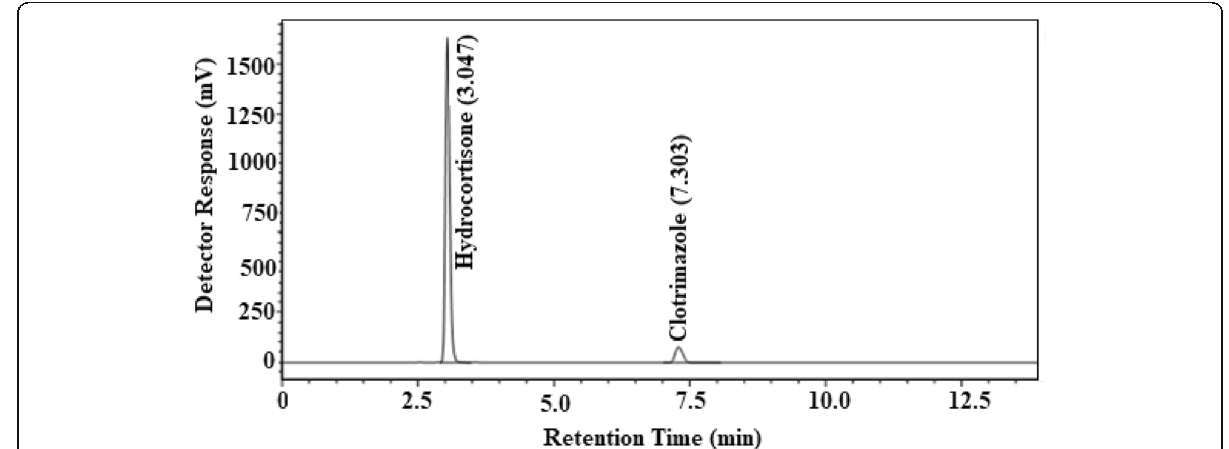
Fig. 4 HPLC chromatogram of topical cream stress testing at 40 °C ± 2/75% ± 5 RH (after 6